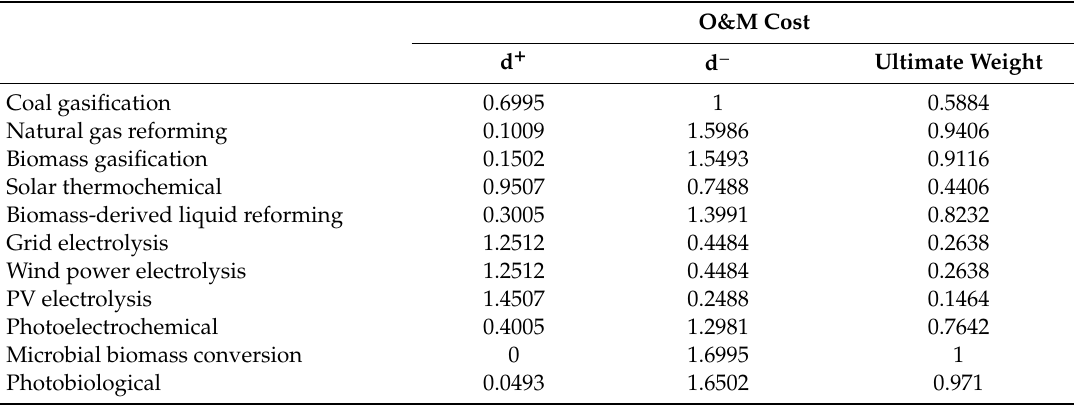
Table A4. Distance from FPIS and FNIS, and ultimate weights of O&M